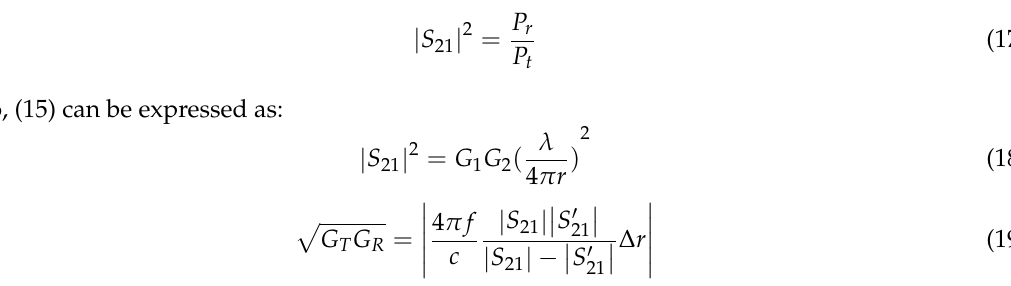
Figure 19. Radiation efficiency over working frequency. In addition, the measured and simulated 2-D and 3-D radiation patterns are illustrated in graphs and pictures below for three different resonance frequencies of 800 MHz, 1150 MHz, and 1600 MHz. In the results, the φ and θ spherical coordinates are related to the Cartesian axis's configurations. For example, θ = − 180 degrees to 180 degrees and φ = 0 degree is the XZ-plane, θ = − 180 degrees to 180 degrees, and φ = 90 degrees is the YZ-plane and φ = 0 degree to 360 degrees is the XY-plane whereas φ = 90 degrees. The XZ-plane ( φ = 0 degree) is considered as E-plane and XY-plane ( θ = 90 degrees) is considered as H-plane. 2-D patterns are shown in Figure 20 where red lines are measured results and blue lines are simulated results. From the far field measurement, the fabricated UWB antenna is directional and the main radiation direction is towards the ground and the key lobes of the radiation patterns are entirely towards the ground over the whole frequency band. The stable radiation pattern of the UWB antenna guarantees that the scattered signals have low noise density at the backward direction.